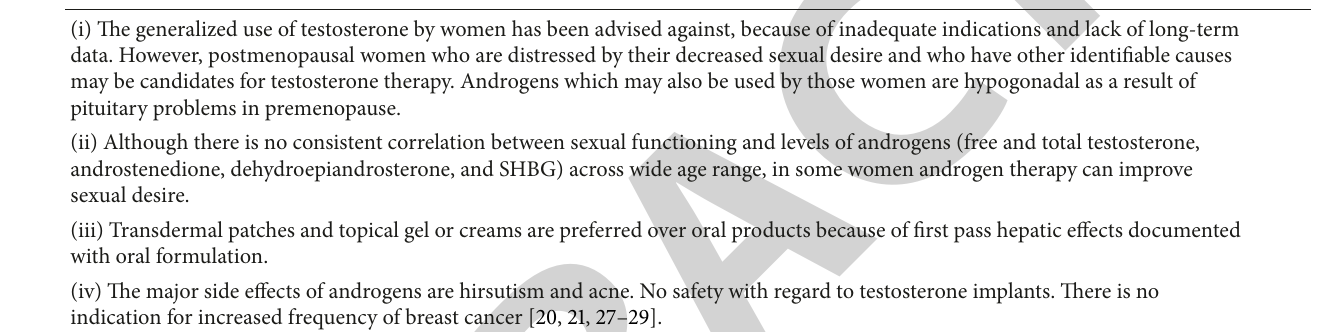
Table 2: What the guidelines say you should do: treatment of sexual dysfunction in women and the opportunity for psychosexual and/or couples